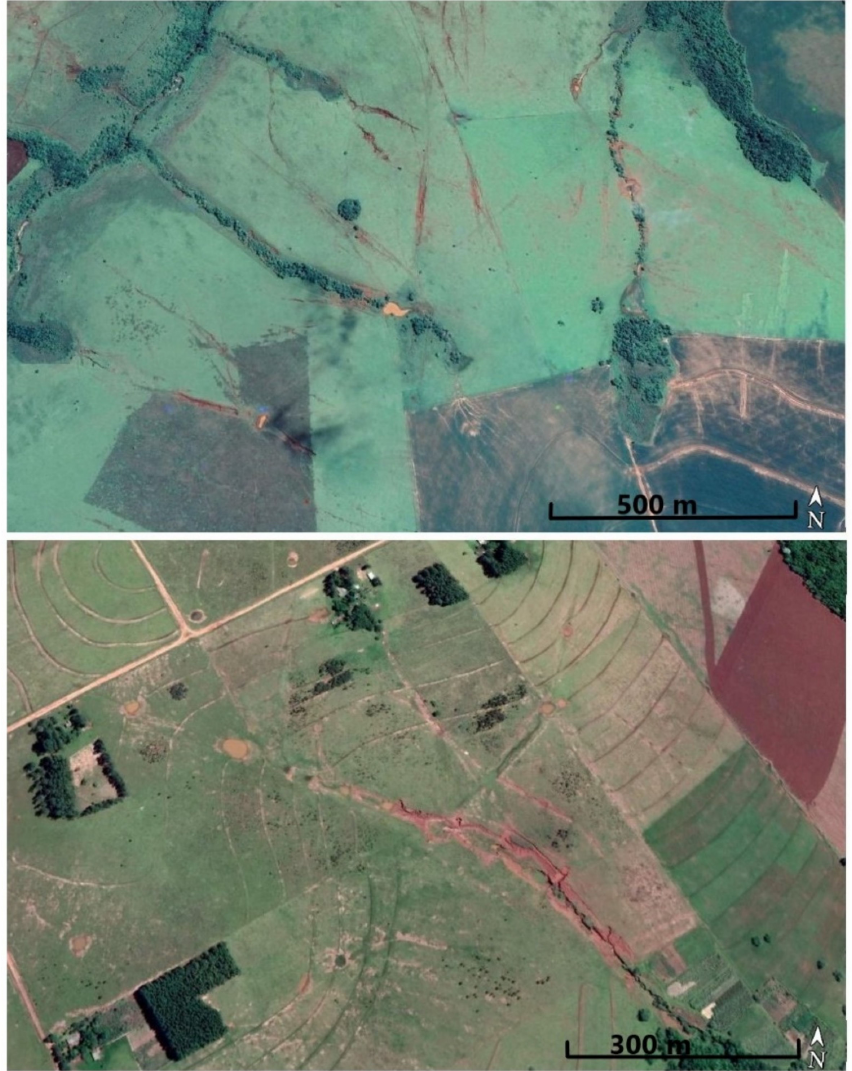
Figure 12. Examples of gullies originating near artificial